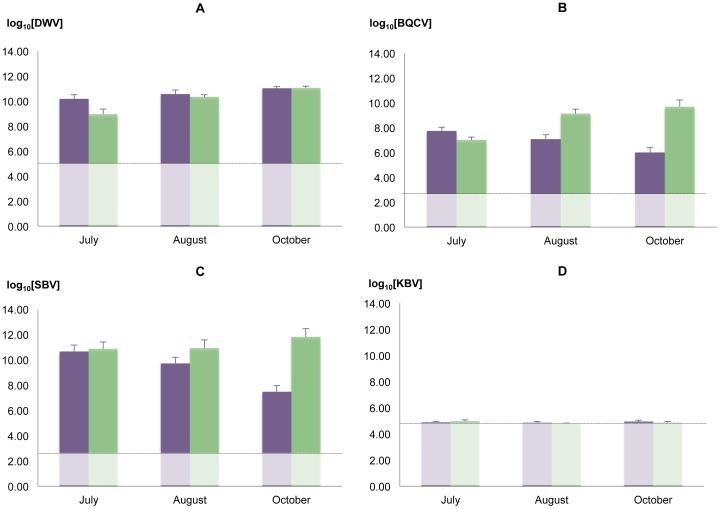
Virus infection dynamics.Virus titres in adult bees (mean values with standard error bars) of (A) deformed wing virus (DWV), (B) black queen cell virus (BQCV), (C) Sacbrood virus (SBV) and (D) Kashmir bee virus (KBV) in mite-resistant (MR) colonies (purple bars) and mite-susceptible (MS) colonies (green bars) from late summer to autumn of 2009 on Gotland, Sweden. The broken line and opaque in each graph area represent the RT-qPCR detection threshold.